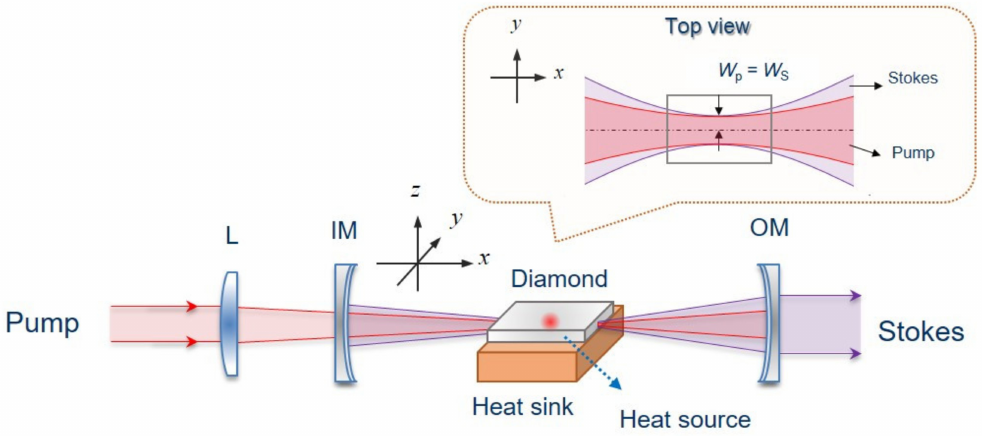
Figure 1. Illustration of the DRL for simulation (inset: top view of the beam propagation in the diamond).